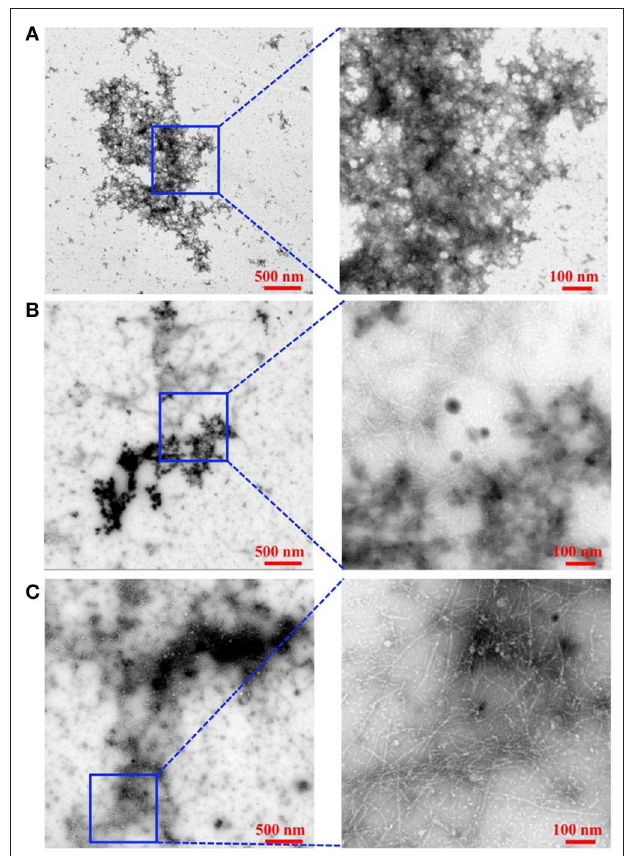
FIGURE 4 | Influence of Ru-N-1 and Ru-N-4 on the aggregation profile of A β 1 − 42. TEM of A β 1 − 42 alone (A) , A β 1 − 42 with 1 eq. of Ru-N-1 (B), and A β 1 − 42 with 1 eq. of Ru-N-4 (C) incubated for 24h with agitation at 37 ◦ C. Box shows where higher magnification image was obtained.